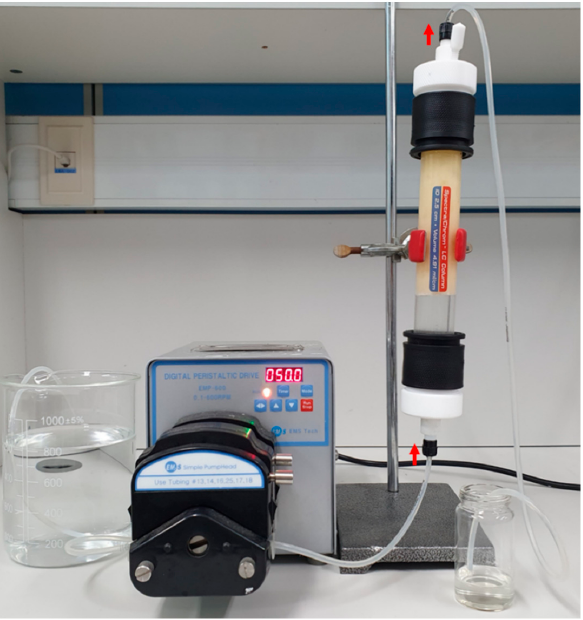
Figure 3. Demonstration of a trace amount of Cu 2+ and Cd 2+ sorption test of ADH-PAMH 1.75 (flow directions are designated with red arrows). directions are designated with red